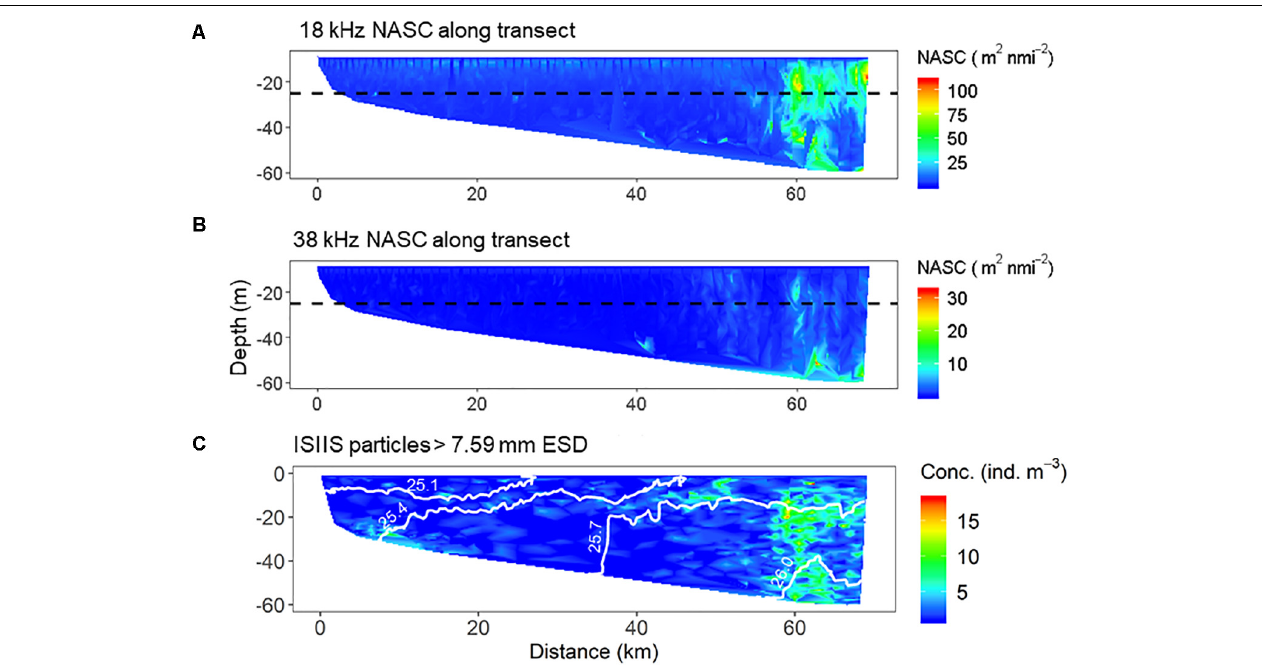
FIGURE 11 | Distribution of NASC (acoustic backscatter) for the (A) 18 kHz and (B) 38 kHz transducers. (C) Abundance of particles larger than 7.59 mm ESD as detected by the ISIIS along the same transect.